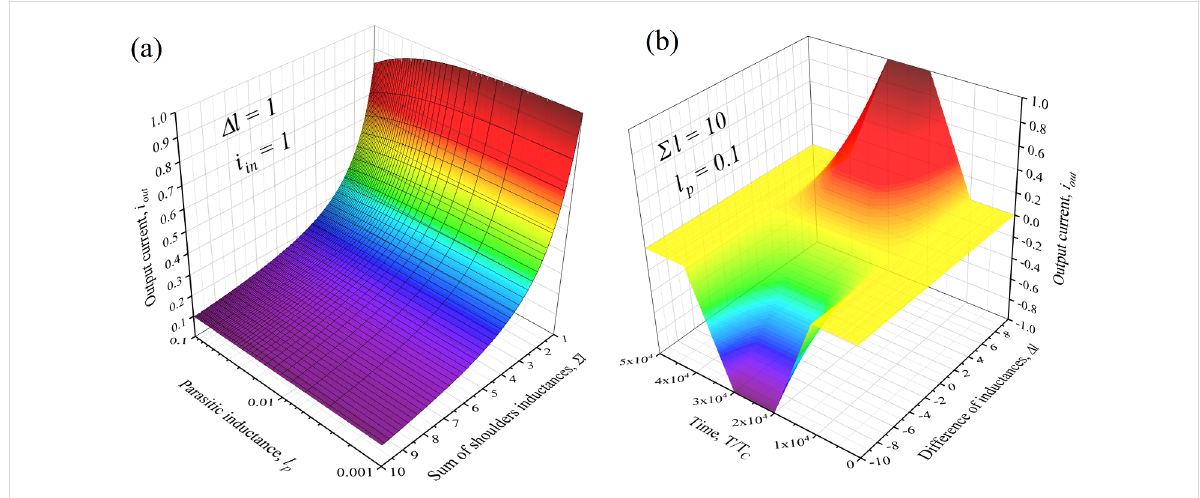
Figure 6: (a) The output current, i out , of the inductive synapse versus the geometric inductance, l p , and the sum of the controlled kinetic inductors of the arms, Σ l . (b) The output current under the action of a single input pulse for different values of the difference between the inductors of the arms, Δ l .